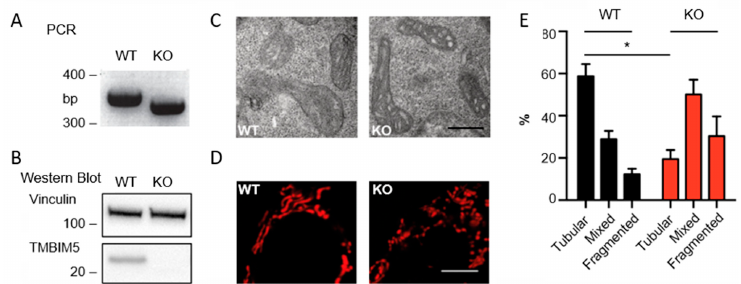
Figure 1. Lack of TMBIM5 results in fragmented and vacuole-like mitochondria. ( A ) PCR demonstrating a 32 bp deletion in HAP1 TMBIM5-KO (knockout, KO) cells. ( B ) Immunoblot verifying loss of TMBIM5 protein expression (observed molecular weight at 25 kDa) in HAP1 TMBIM5-KO cells. Vinculin served as loading control, size is indicated. ( C ) TMBIM5-KO cells exhibit vacuoles, containing low density material and shrunk cristae structures (scale bar: 500 nm) in transmission electron microscopy. ( D ) Mitochondria in HAP1 wild-type (WT) and TMBIM5-KO cells stained with MitoTracker ™ Red CMXRos (scale bar: 3 µ m). ( E ) More than 100 cells from each cell line were imaged by confocal microscopy and categorized according to mitochondrial morphology as tubular, mixed, or fragmented.